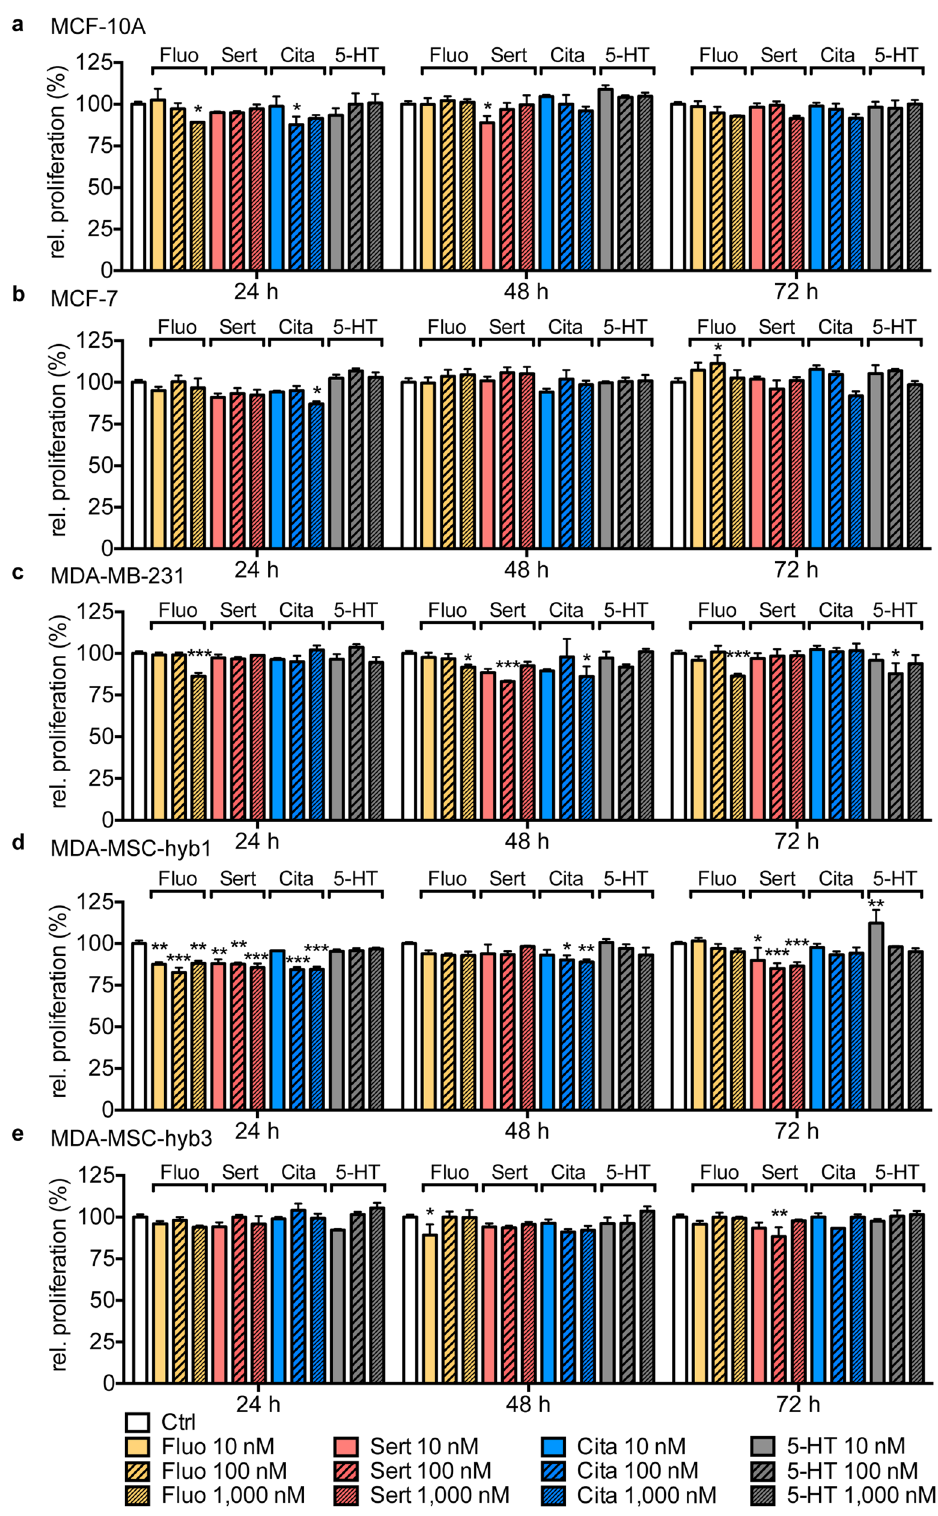
Figure 1. SSRI treatment or 5-HT exposure marginally impact cell proliferation of breast cancer cell lines. Bar graphs depict relative proliferation assessed by Fluoroskan of MCF-10A ( a ), MCF-7 ( b ), MDA-MB-231 ( c ), MDA-MSC-hyb1 ( d ) and MDA- MSC-hyb3 ( e ) cells in response to treatment with 10 nM, 100 nM or 1000 nM fluoxetine (Fluo; yellow), sertraline (Sert; red), citalopram (Cita; blue) or 5-HT (grey) for indicated time periods normalized to DMSO-treated control cells (Ctrl; white). Data are depicted as mean ± SEM and summarize n = 9–10 (Ctrl) and at least n = 3 (SSRI/5-HT) experiments. P -values were determined by two-way ANOVA followed by Dunnett’s multiple comparison test; *** P < 0.001; ** P < 0.01; * P < 0.05 versus corresponding